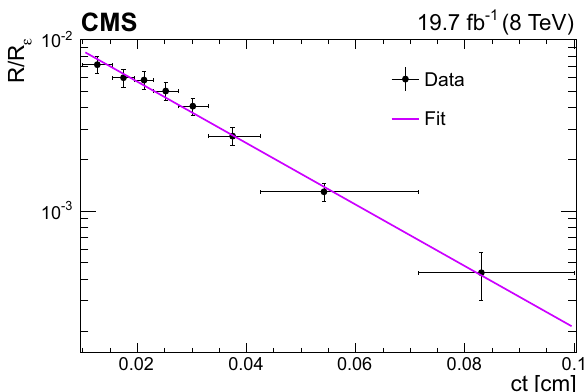
Fig. 7 Ratio of the B + c to B + efficiency-corrected ct distributions, R / R ε ,withalineshowingtheresultofthefittoanexponentialfunction. The vertical bars give the statistical uncertainty in the data, and the horizontal bars show the bin